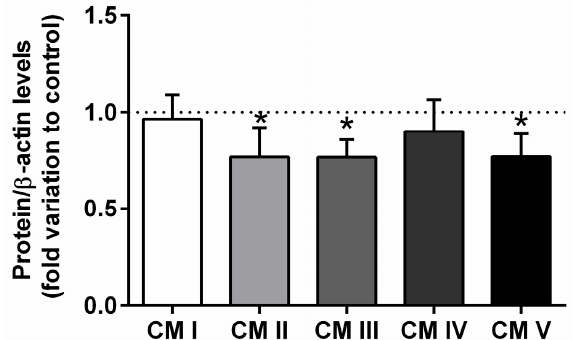
11.89 ± 0.74 U/mg of protein (Figure 4d). Contrastingly, we measured the activity of GR in the epididymal tissue, which was significantly increased by 30%, from 0.14 ± 0.03 U/mg of protein in the animals of the control group to 0.20 ± 0.02 U/mg of protein in those of the T2DM group (SP = 61%) (Figure 4e).